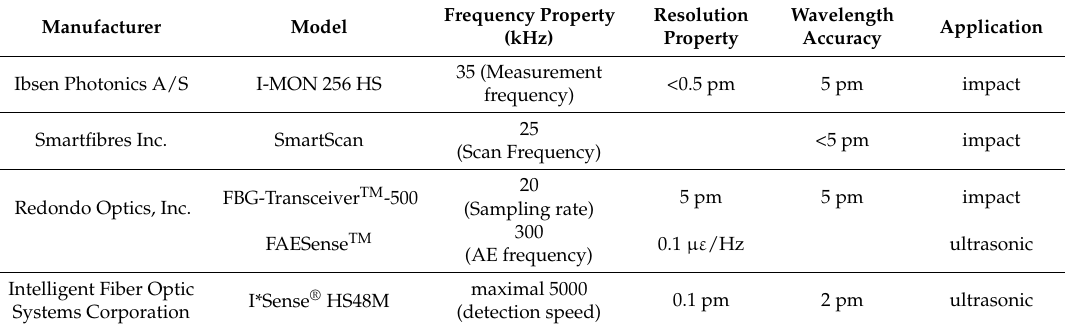
Table 1. The commercial FBG sensors and their